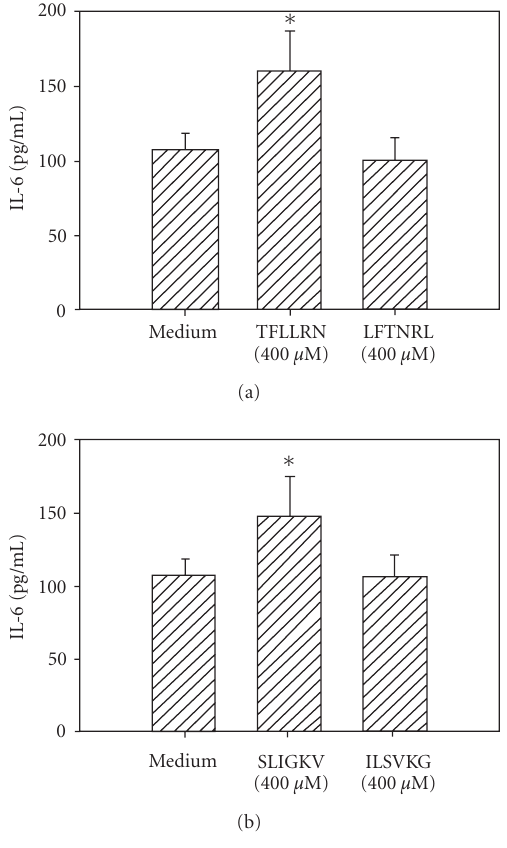
Figure 3: PAR1 and PAR2 agonist peptides stimulate IL-6 produc- tion in HCECs . HCEC monolayers were incubated with PAR1 ago- nist peptide (TFLLRN) or scrambled peptide (LFTNRL) (a), or with the PAR2 agonist peptide (SLIGKV) or inactive peptide (ILSVKG) (b). After 24 hours, IL-6 levels in the culture media were assayed by ELISA. Each value presented is the mean + / − SD of quadruplicate determinations. The results presented are representatives of six in- dependent experiments. ∗ indicates P < .05 when compared to medium